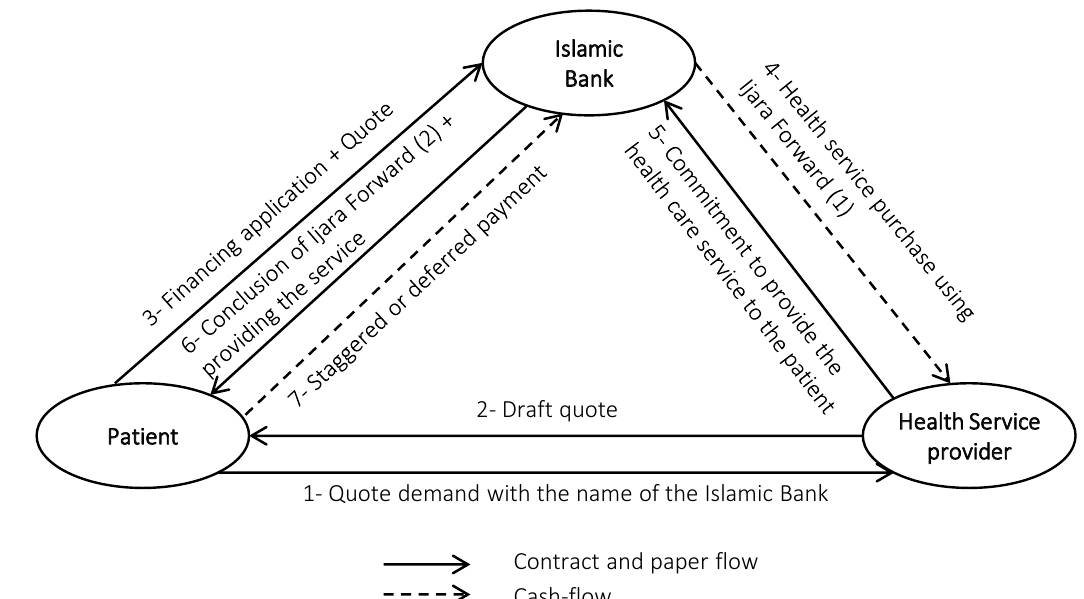
Figure 1. The most used formula for financing health expenditure through Ijara Forward